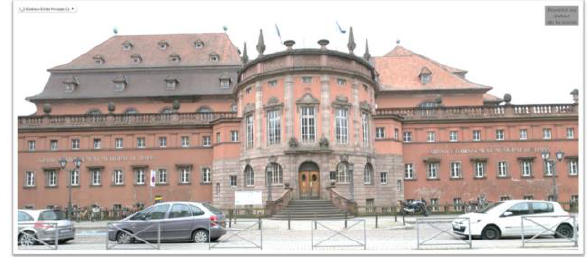
Figure 1: Main façade and entrance of the Baths of